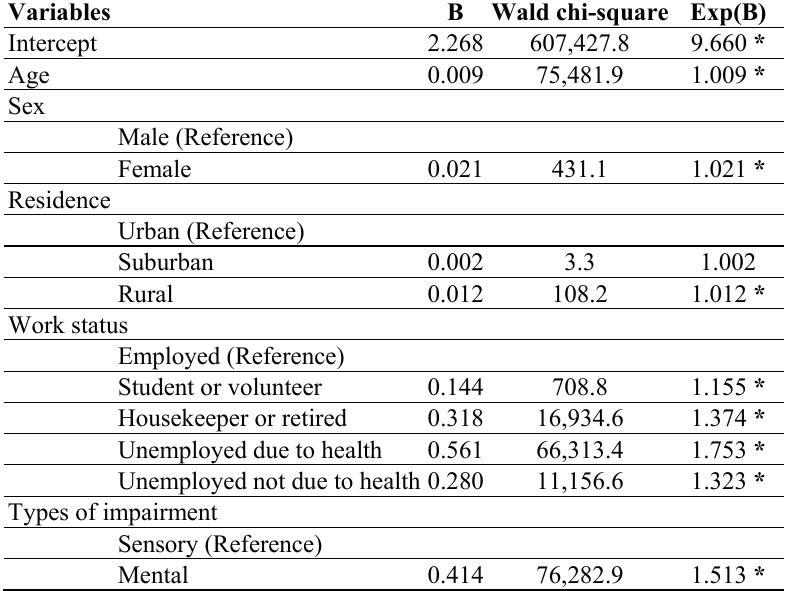
Table 3. Poisson regression of WHODAS 2.0 scores and associated